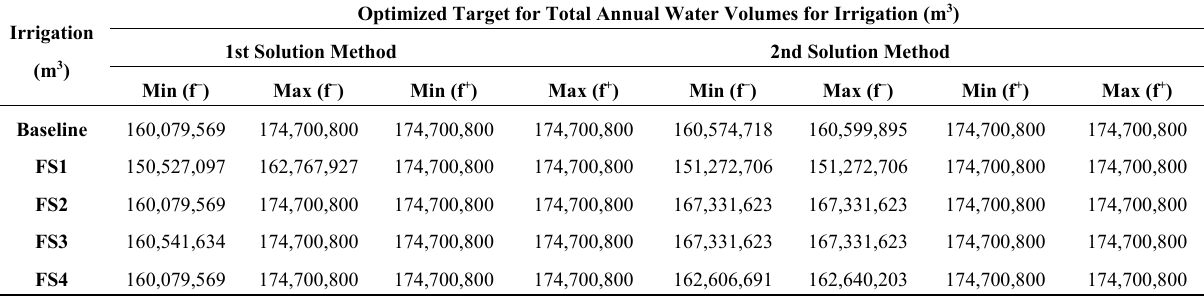
Table 12. Optimized target for total annual water volumes for irrigation (m 3